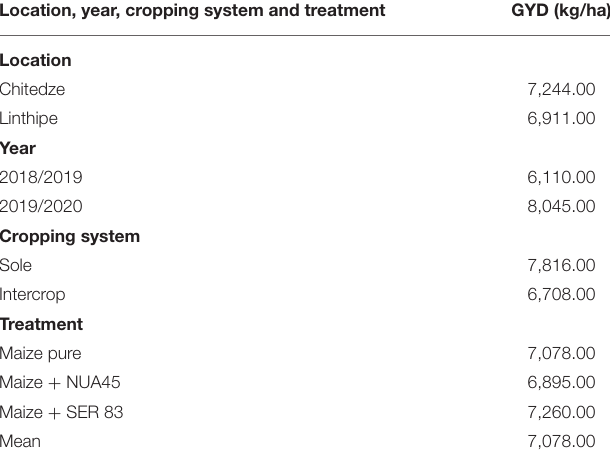
TABLE 8 | Means of location, year, cropping system, treatment, and contrast for grain yield of maize from a maize common bean intercropping at Chitedze and Linthipe in 2019 and